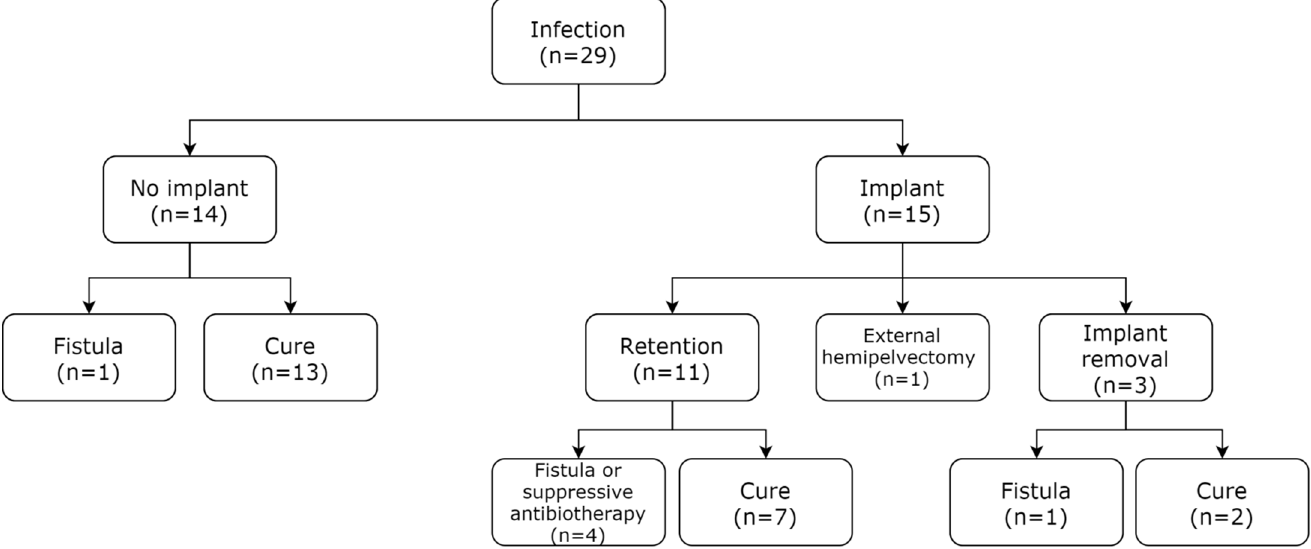
Figure 2. Outcomes for 29 patients with a pelvic tumor resection affected by infection and treated initially by debridement and antibiotics (DA) or debridement, antibiotics, and implant retention (DAIR).